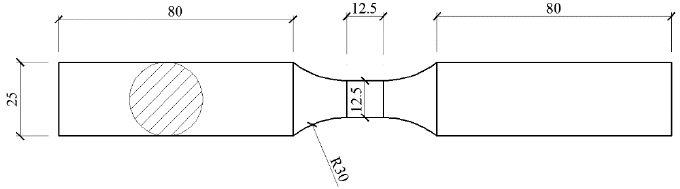
Figure 1. Small-gauge-length specimen.